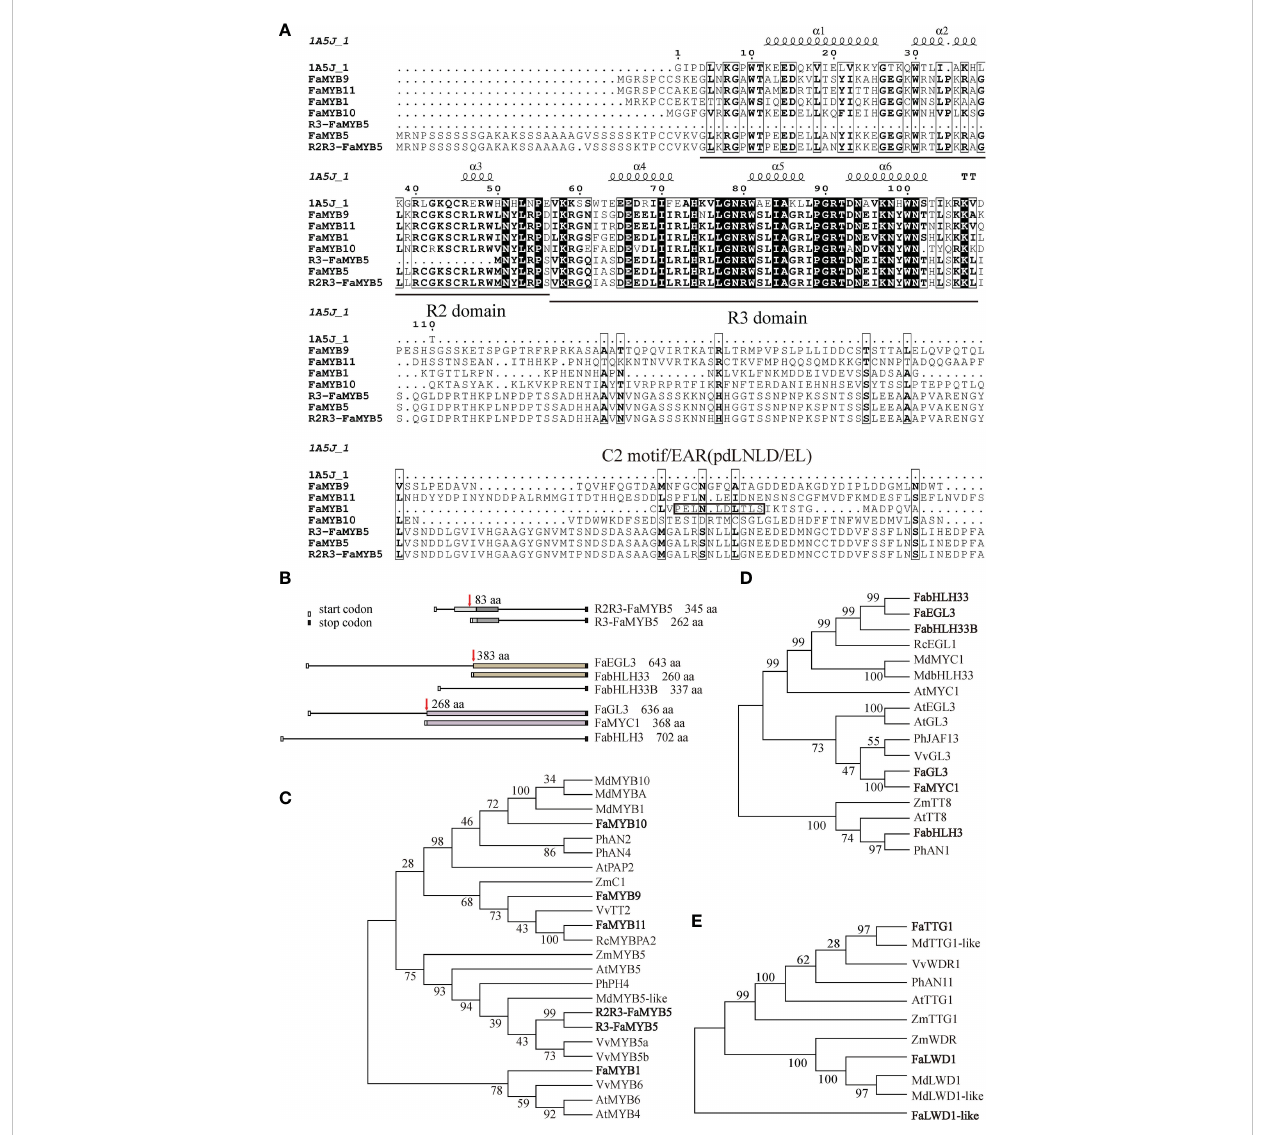
FIGURE 1 Bioinformatic analysis of 15 identi fi ed strawberry transcriptional regulators. (A) Multiple protein sequence alignment of strawberry MYB transcription factors. Reference sequence of 1A5J_1 download from https://www.rcsb.org/structure/1a5j. (B) Sequence model diagrams for different MYBs and bHLHs. The same color box represents the exact same amino acid sequence. (C-E) Phylogenetic analysis of selected MYBs, bHLHs and WD40s